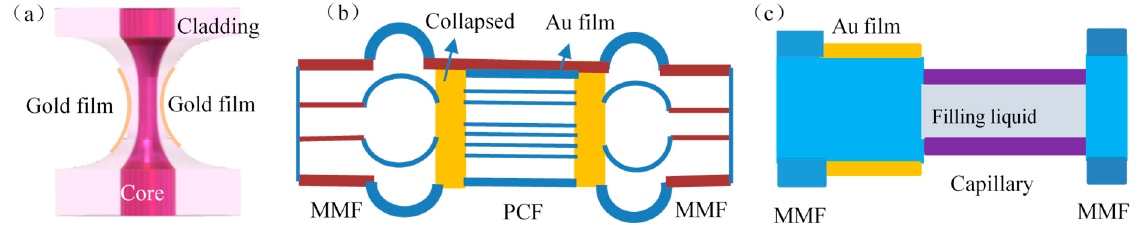
Figure 4. Interferometric Hybrid SPR Structure. ( a ) Tapered structure [45]; ( b ) PCF structure [46]; ( c ) Capillary structure [47].